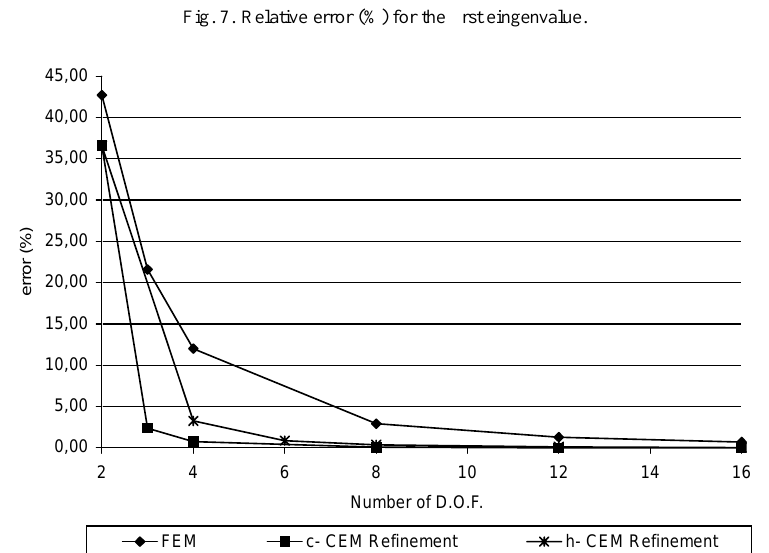
Number of D.O.F.